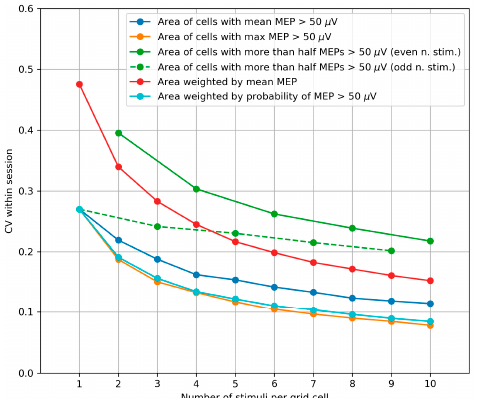
Figure 4. Within-session variability of area parameters measured by the coefficient of variation (CV) of the parameter values obtained in 1000 maps generated by bootstrapping from every initial 10-stimuli-per-cell map of every subject. The median values of the CVs from all maps of all subjects are depicted. For all the parameters, the CV significantly decreases with the number of stimuli per cell ( p < 0.001, Page’s trend test for ordered alternatives).